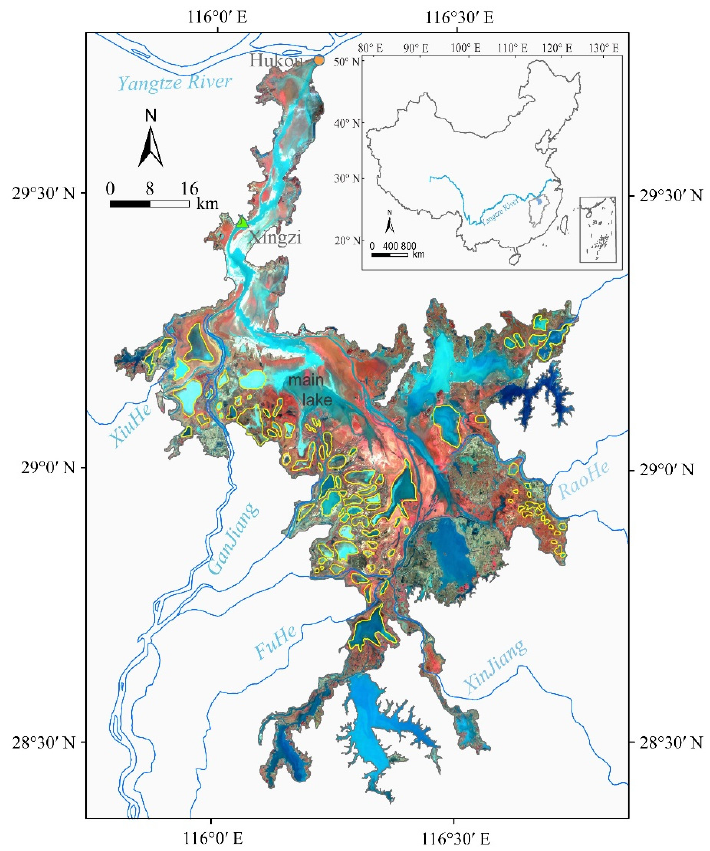
Figure 1. Geographic location of Poyang Lake in China. Yellow outlines delineate saucer-shaped depressions. The base map was produced using a combination of Landsat Thematic Mapper (TM) bands 4, 3, and 2, which were acquired in December 2013.